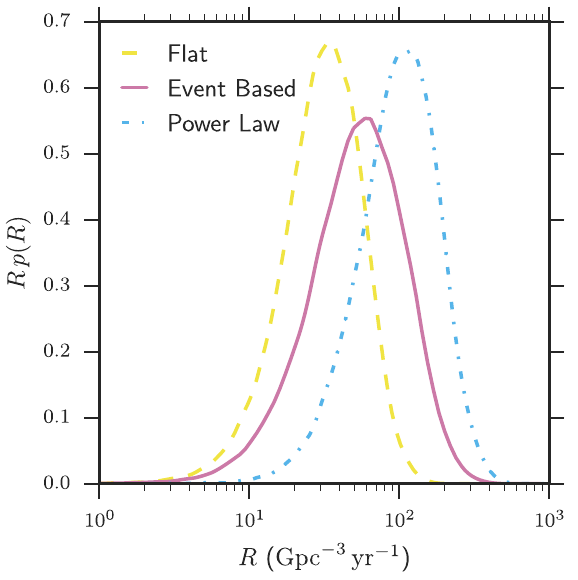
FIG. 11. The posterior density on the rate of BBH mergers. The curves represent the posterior assuming that BBH masses are distributed flat in log ð m 1 Þ − log ð m 2 Þ (Flat), match the properties of the observed events (Event based), or are distributed as a power law in m 1 (Power law). The posterior median rates and symmetric 90% symmetric credible intervals are given in Table